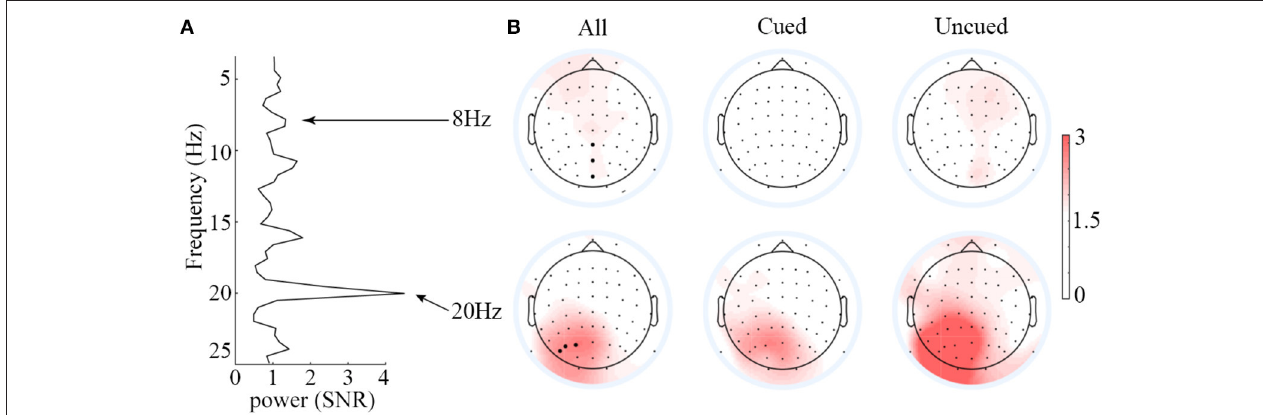
FIGURE 3 | Averaged SNR spectrum of the PO3, PO5, and PO7 electrodes (A) and scalp topographies of the SSVEPs elicited by 8 and 20 Hz flickers (B) . Overall, the SNR of 8-Hz-flicker-elicited SSVEPs was very low, and it is hard to differentiate the signal from noise; the SNR of 20-Hz-flicker-elicited SSVEPs was relatively higher over the left occipitoparietal scalp.